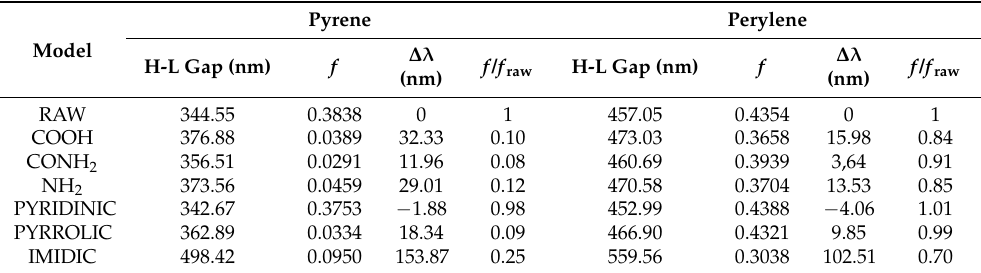
Table 1. Computational results relative to pyrene and perylene models with different dop- ing/functional groups: HOMO-LUMO gap, the oscillator strength, and the differences between these calculated for the raw model and the other models.